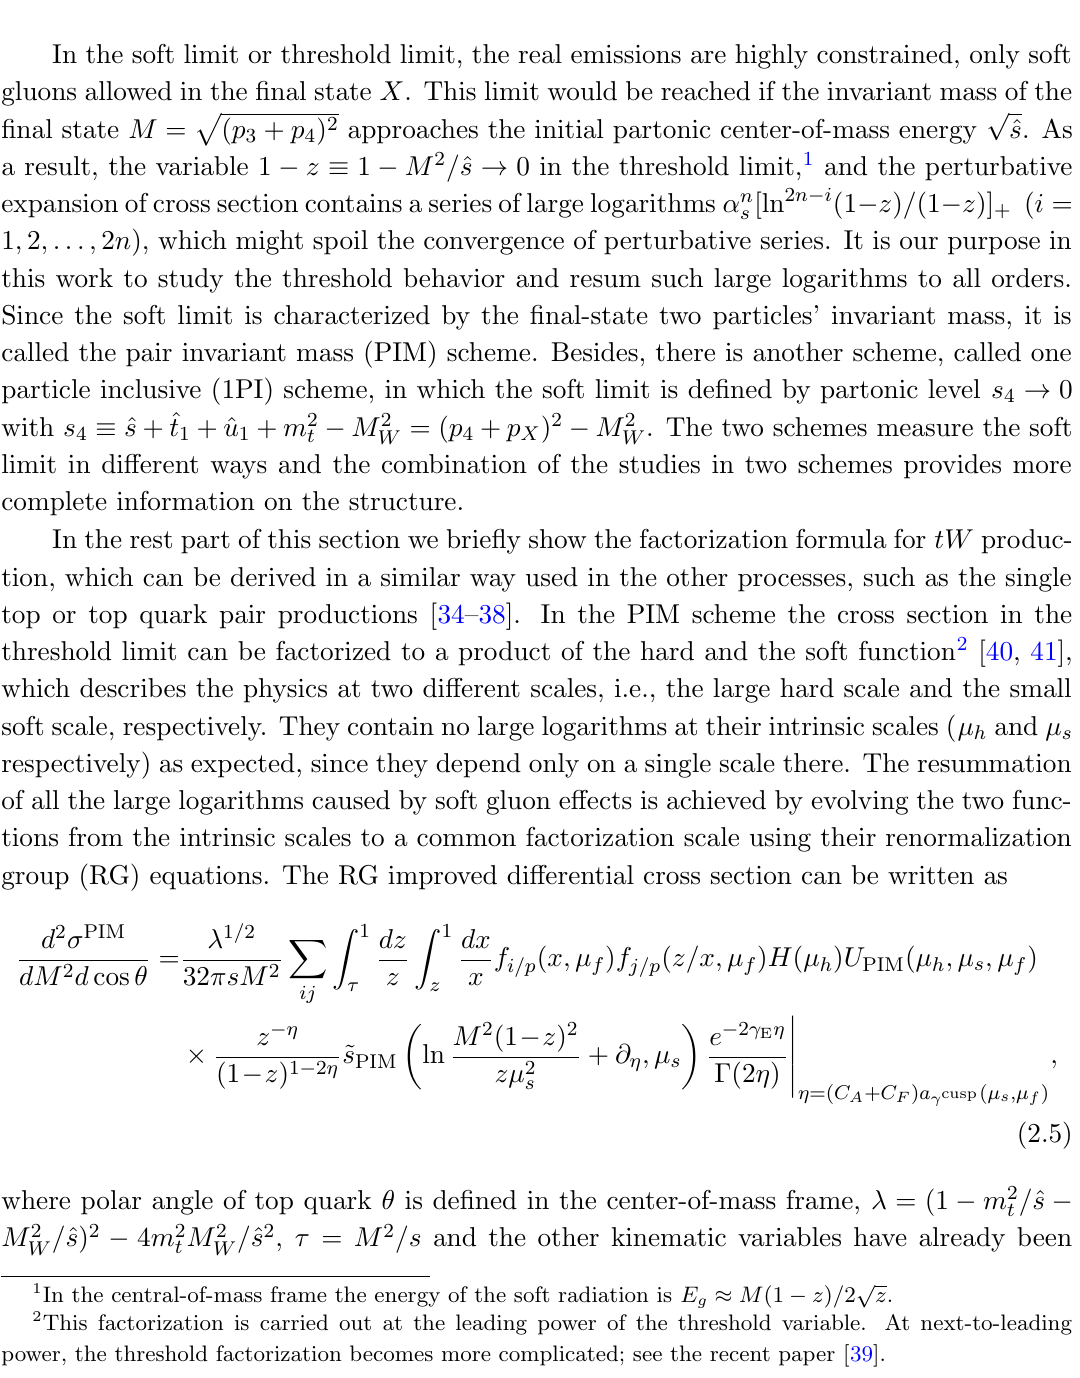
Figure 1 . LO Feynman diagrams for tW (cid:0)